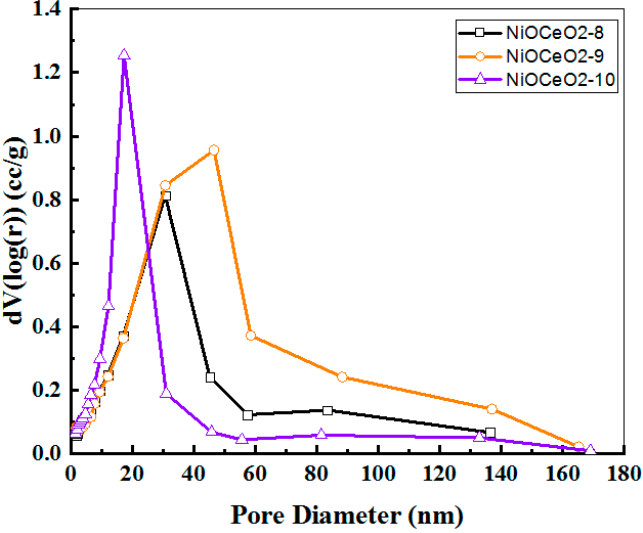
Figure 1. Pore size distribution obtained for NiOCeO 2 -8, NiOCeO 2 -9 and NiOCeO 2 -10 catalysts after calcination at 600 °C.